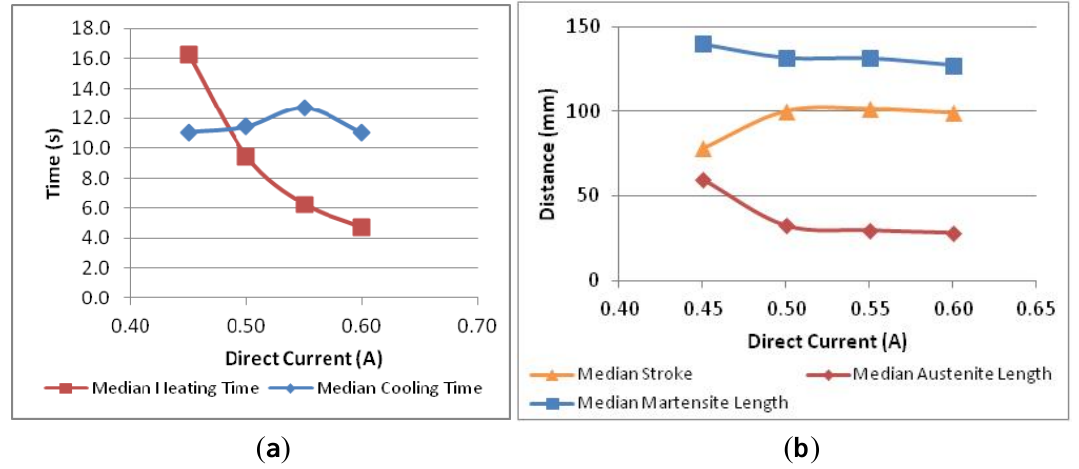
Figure 8. Experimental results from the direct current manipulation. ( a ) (Left) The averaged heat and cooling times. ( b ) (Right) The averaged strokes, martensite lengths and austenite